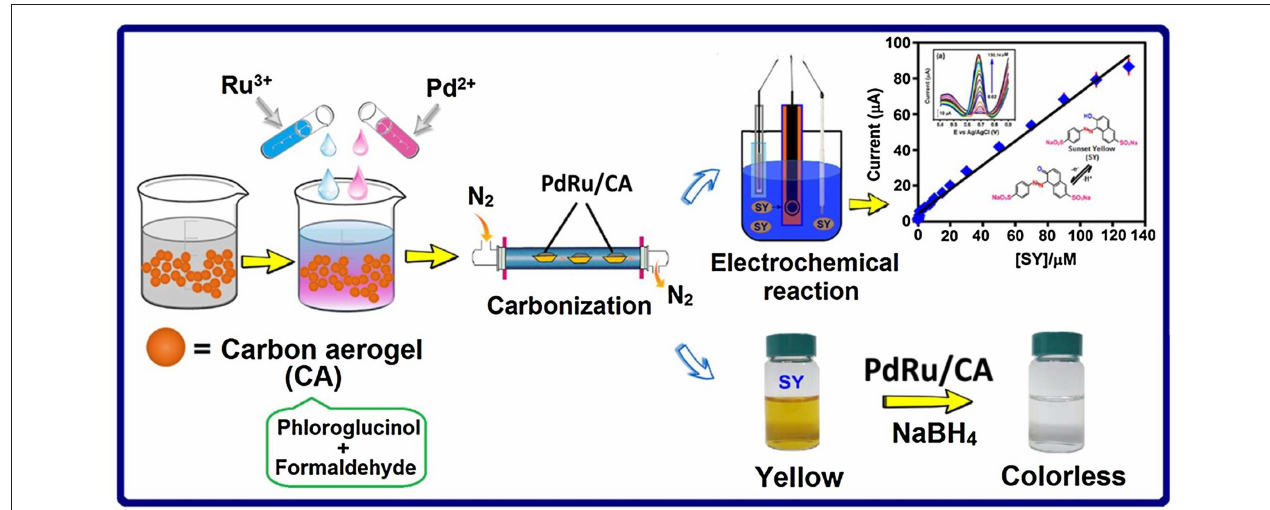
FIGURE 6 | Preparation and application of the PdRu/CA nanocomposite toward sensitive electrochemical detection of SY. Reprinted from Thirumalraj et al. (2018), © 2017, with permission from